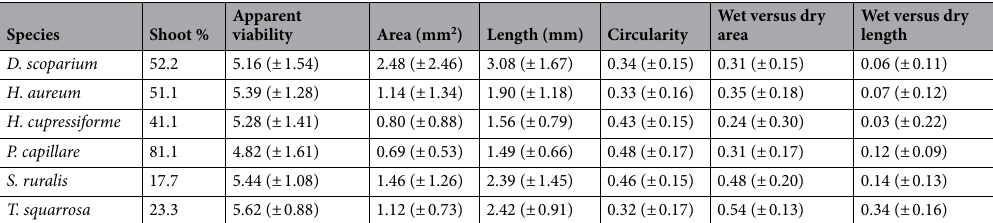
Table 2. Summary of the average values and standard deviations of the size and shape traits for the six analysed species.